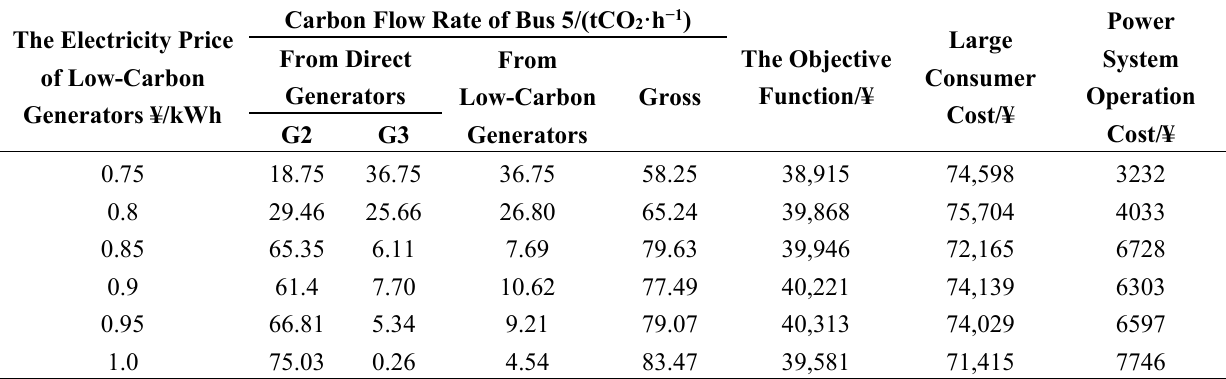
Table 6. Results under the condition of different electricity prices of low-carbon generators. The Electricity